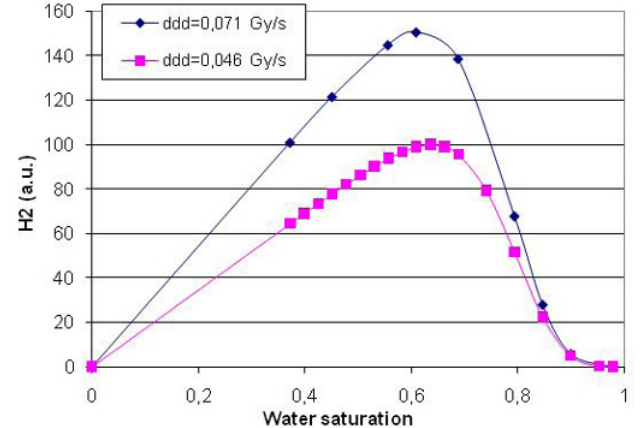
Fig. 4: Dihydrogen production over 100 years vs. water saturation, as a function of  irradiation dose